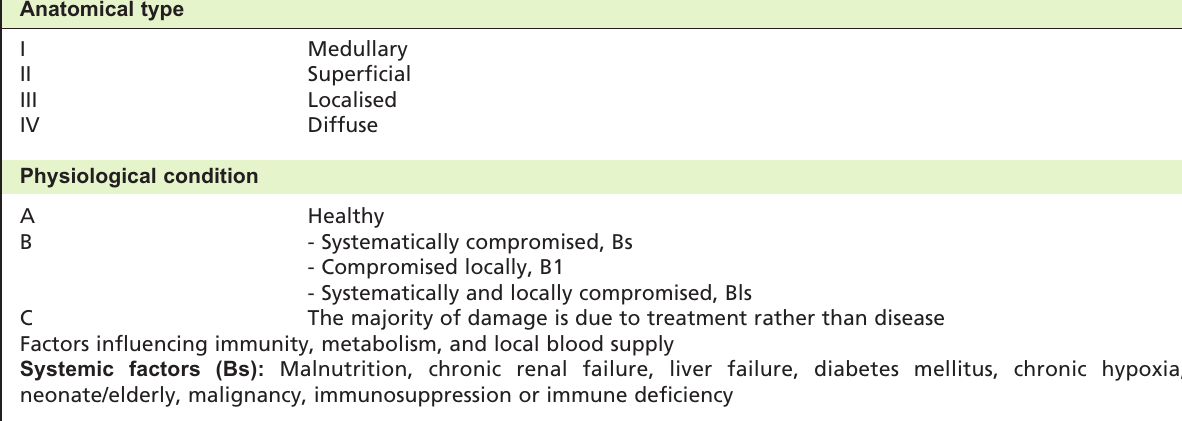
Waldvogel classification of Table II: